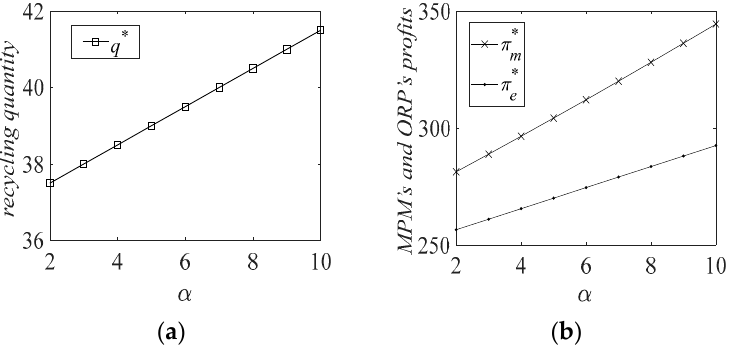
Figure 5. Impact of the voluntary recycling quantity: ( a ) Change in the recycling quantity; ( b ) Changes in the MPM’s and ORP’s profits.